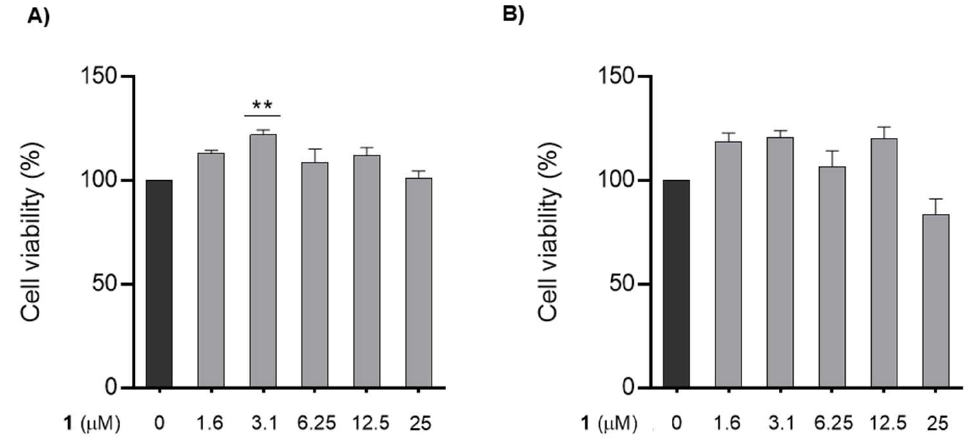
Figure 4. Cell viability assay of cells treated with chalcone 1 (for the sake of simplicity, the chalcone is indicated in the graphics using only the number 1 ). Changes in the viability of the GC-1 cells after being treated with different concentrations of chalcone 1 (0–25 µ M) for ( A ) 7 h and ( B ) 13 h. The percentage of viable cells for each condition was plotted as mean ± SEM of five independent experiments, performed in duplicate. Values are expressed as arbitrary units, and the cell viability of the control condition is given a value of 100. ** p < 0.01 compared to the control group, using a nonparametric Kruskal–Wallis one-way ANOVA test.